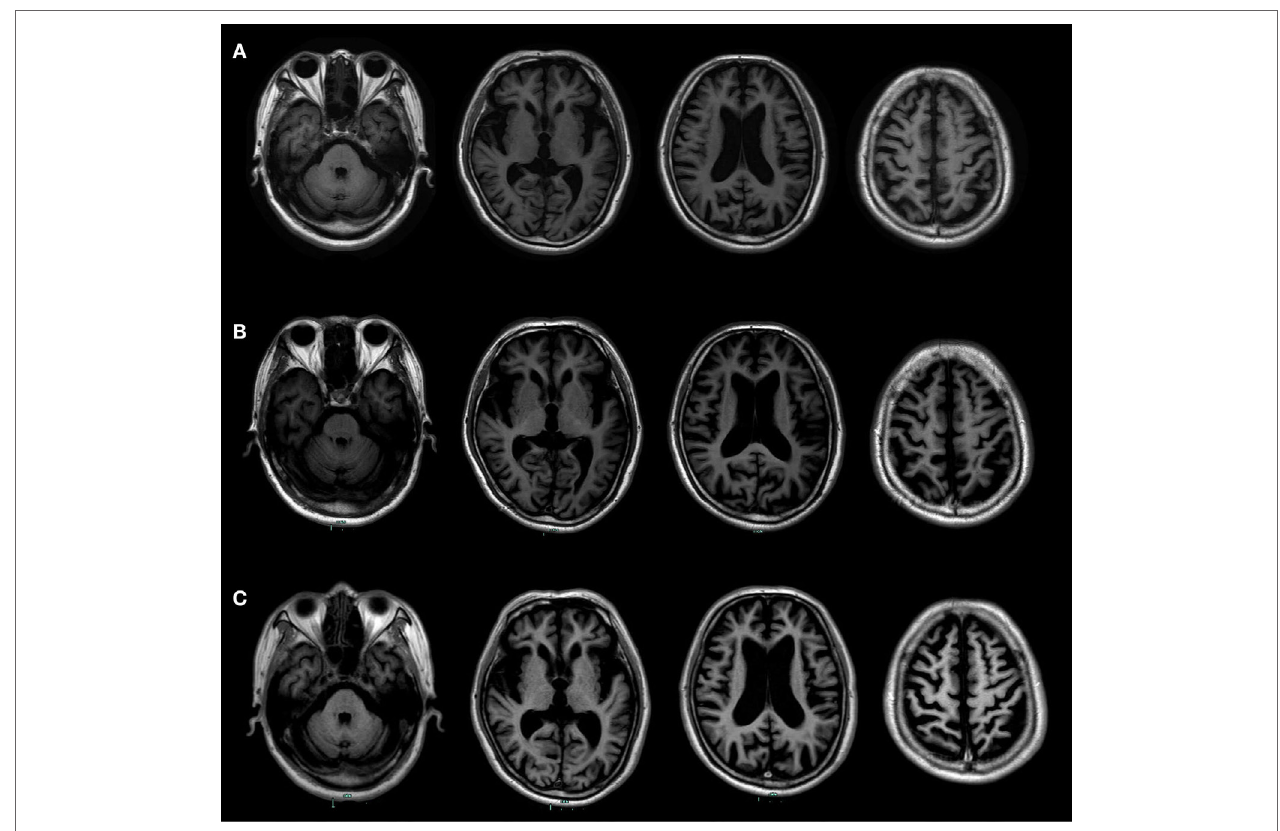
FIgURe 1 | Longitudinal structural MRI scans showed progressive brain atrophy. (a) It was performed at the age of 73. (b) It was performed at the age of 74. (C) It was performed at the age of 76. Those follow-up MRI scans indicated asymmetric atrophy of the frontal, temporal, and parietal lobes that was more pronounced on the left side of the brain, especially on the left inferior frontal and